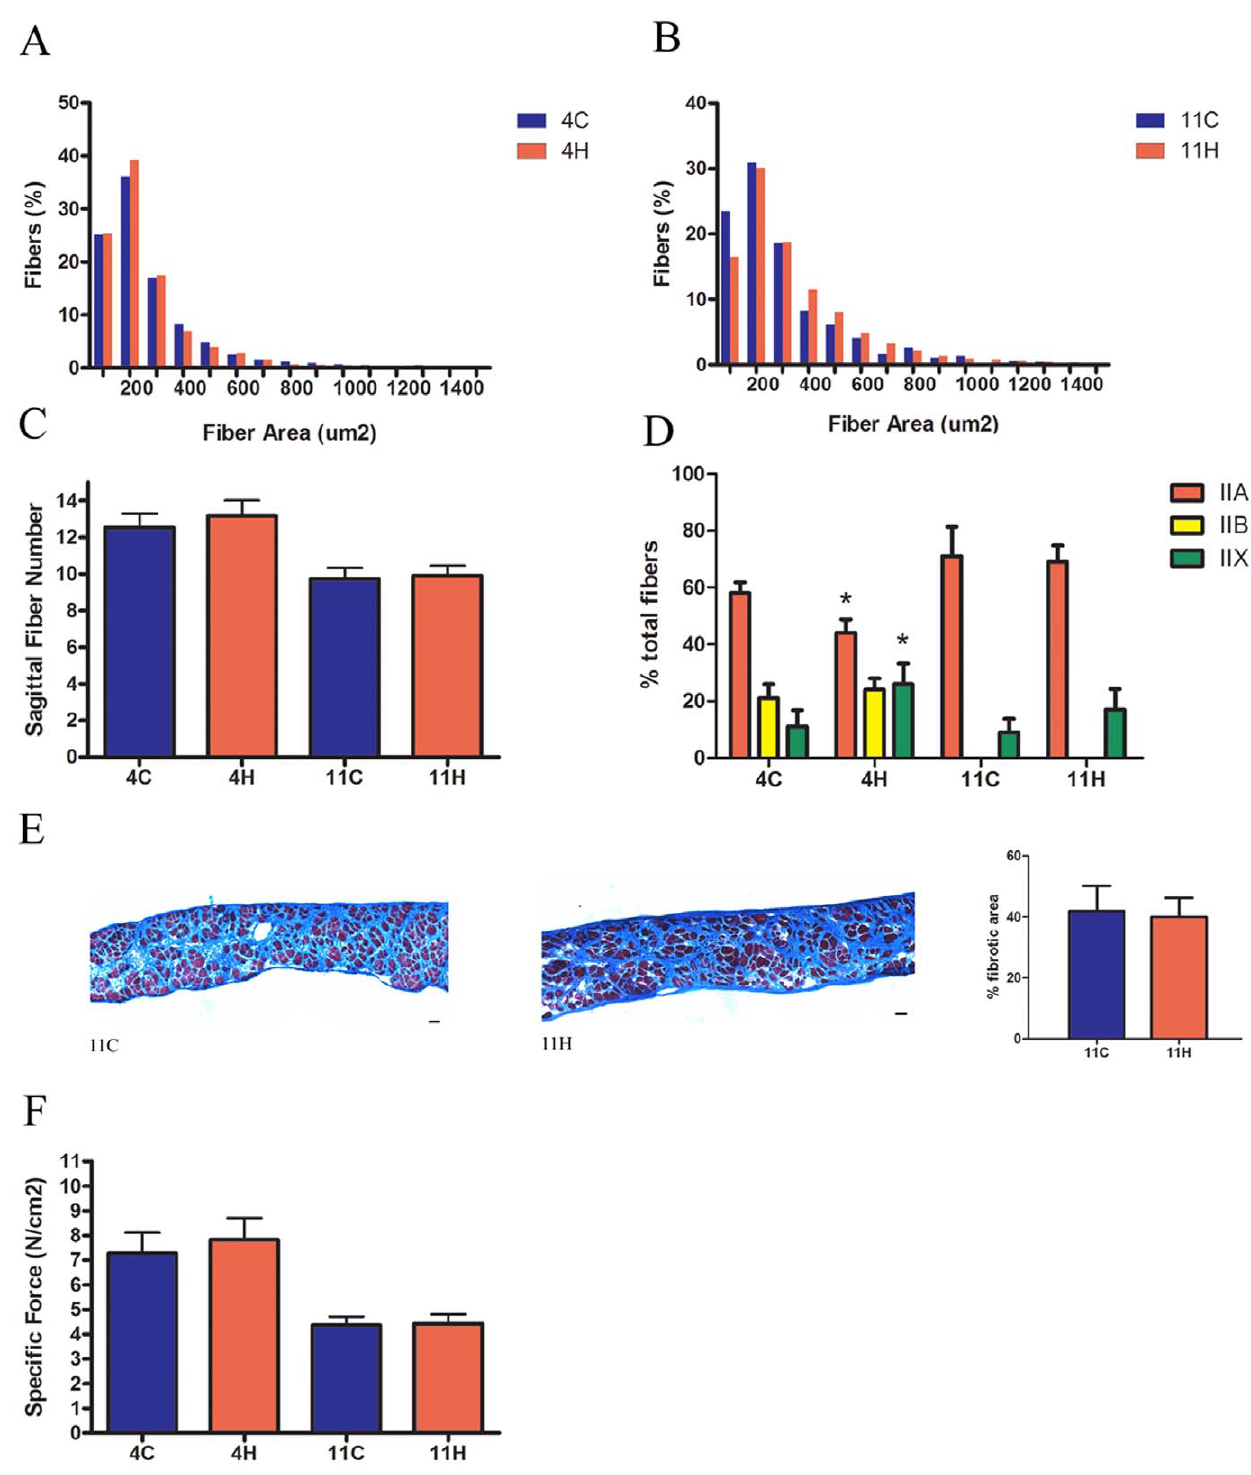
Figure 7. Morphological properties and force production of the mdx diaphragm. (a,b) Fiber size distributions were unaltered by myostatin inhibition in the mdx 4H and mdx 11H groups. (c) The number of fibers across the sagittal plane of the diaphragm, a measure of diaphragm fiber number, did not change at either time point. (d) In the mdx 4H diaphragm there were more type IIX fibers and less type IIA fibers. No changes in fiber type were observed in the mdx 11H group. (e) Masson’s trichrome stained diaphragm sections did not demonstrate a difference in fibrotic area in the mdx 11H diaphragm in comparison to control (11C). (f) Overexpression of dnMstat did not improve specific force production in the diaphragm. Data represent mean 6 SD. * Statistically significant compared to control, p , 0.05. Scale bar: 50 m m.